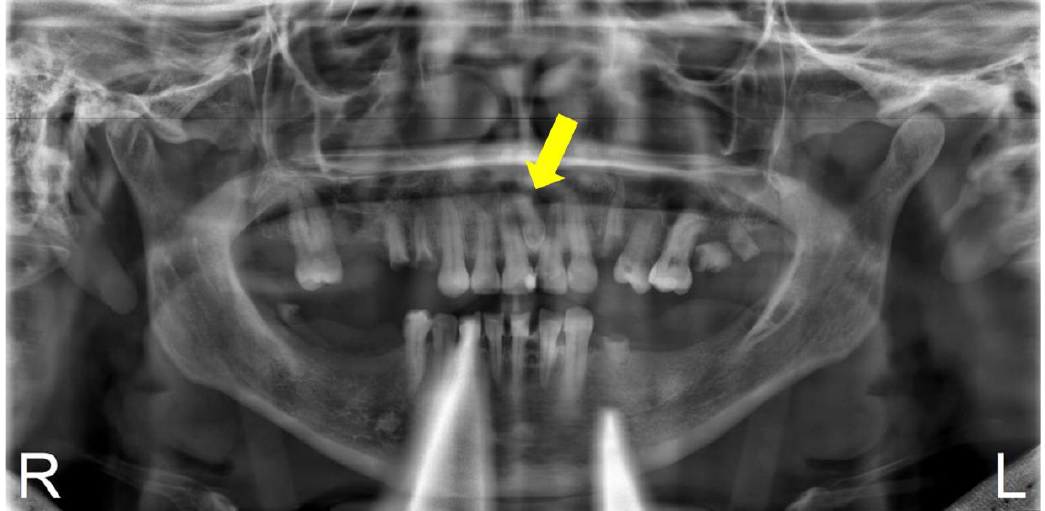
Figure 3. Panoramic X-ray. Bimaxillary partial edentulousness. Presence of multiple root remnants. The presence of supernumerary tooth located between teeth 1.1 and 2.1 is observed. Yellow arrows — location of mesiodens.